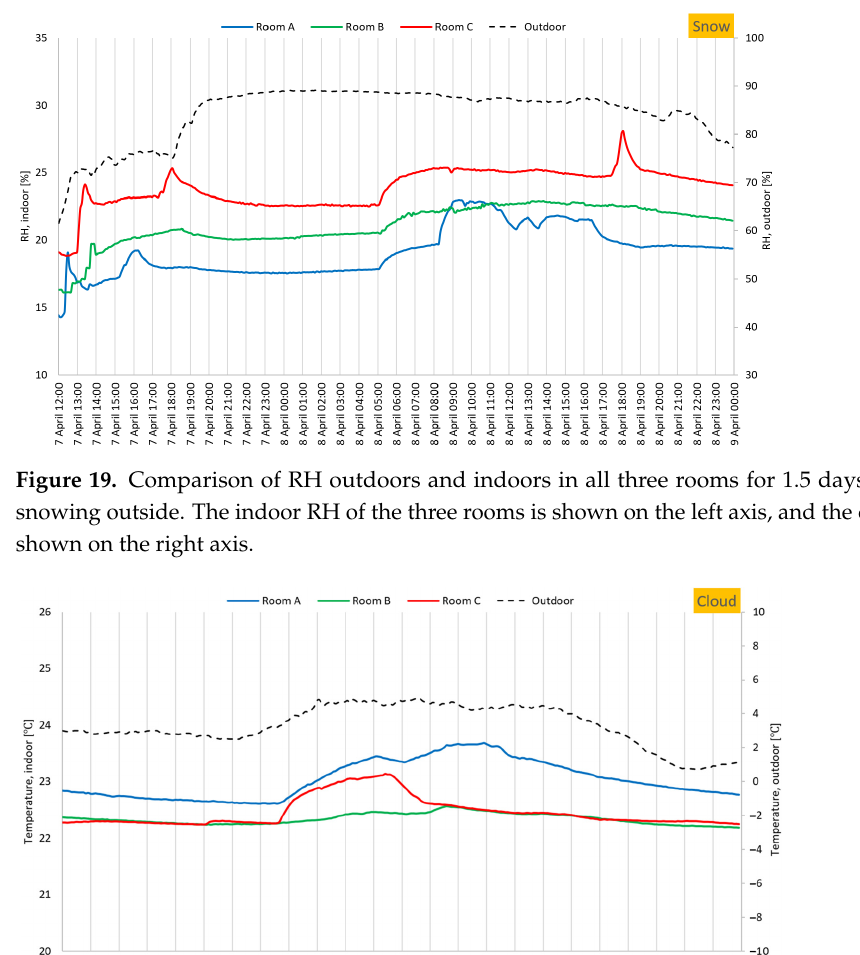
Figure 18. Comparison of temperature outdoors and indoors in all three rooms for 1.5 days when it was snowing outside. The indoor temperature of the three rooms is shown on the left axis, and the outdoor temperature is shown on the right axis.